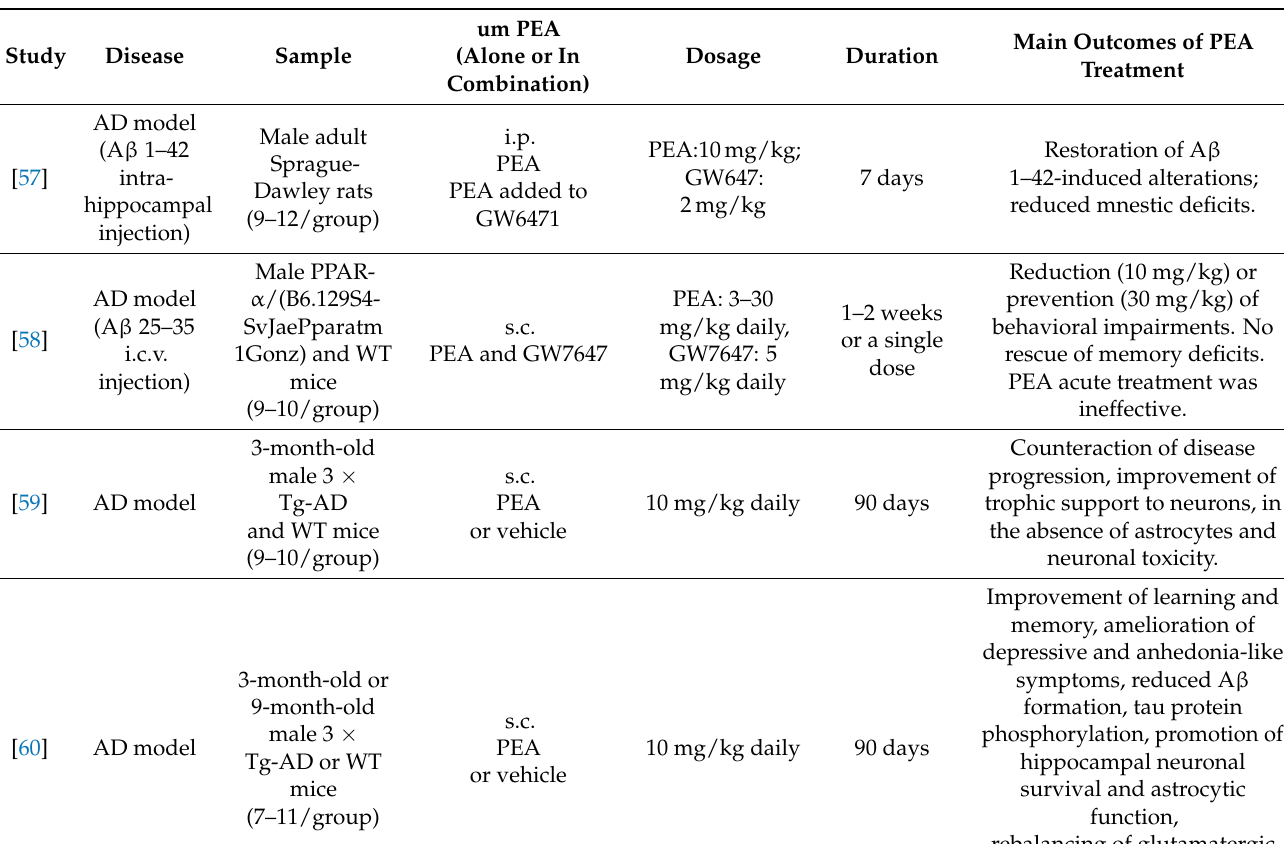
Table 2. Summary of experimental studies using PEA in the presence of